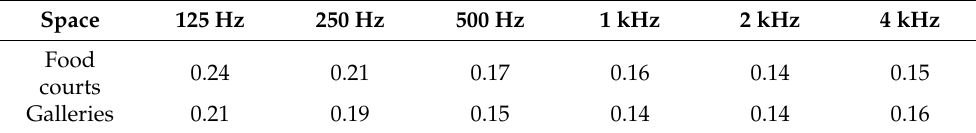
Figure 5. Absorption coefficients of food courts ( a ) and galleries ( b ). Table 7. Average absorption coefficients. Table 7. Average absorption